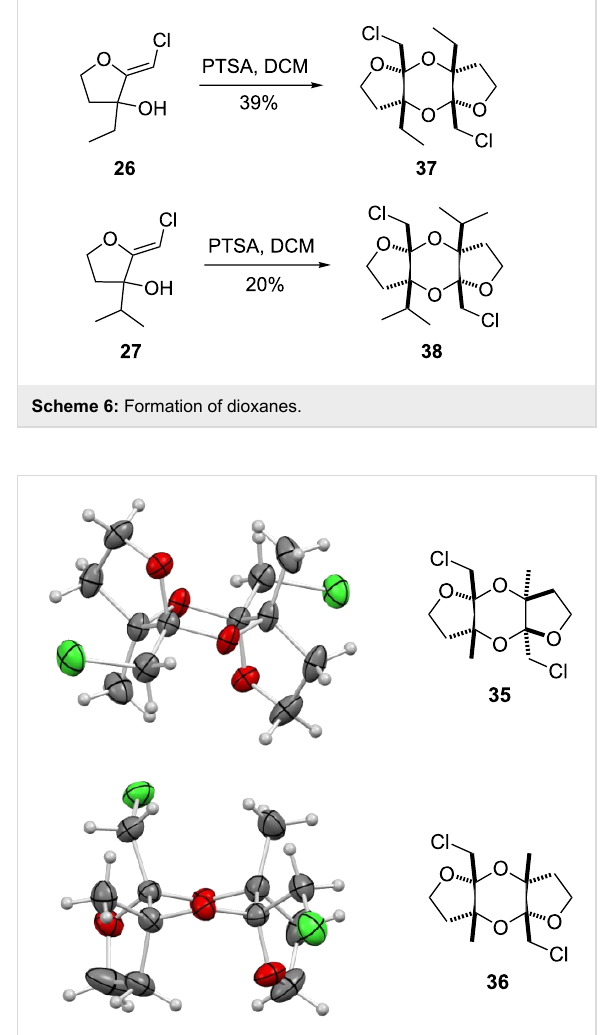
Figure 1: X-ray diffraction analysis of dioxanes 35 and 36 .